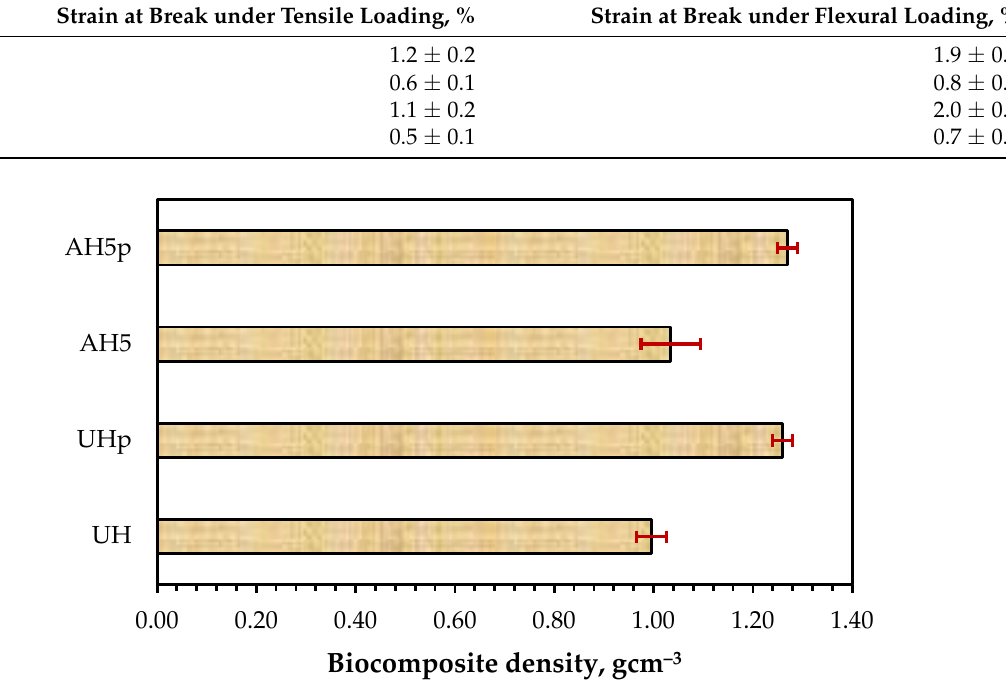
Table 3. Comparing the strain at break of the FR-coated biocomposites with the non-FR-coated batches. Composites